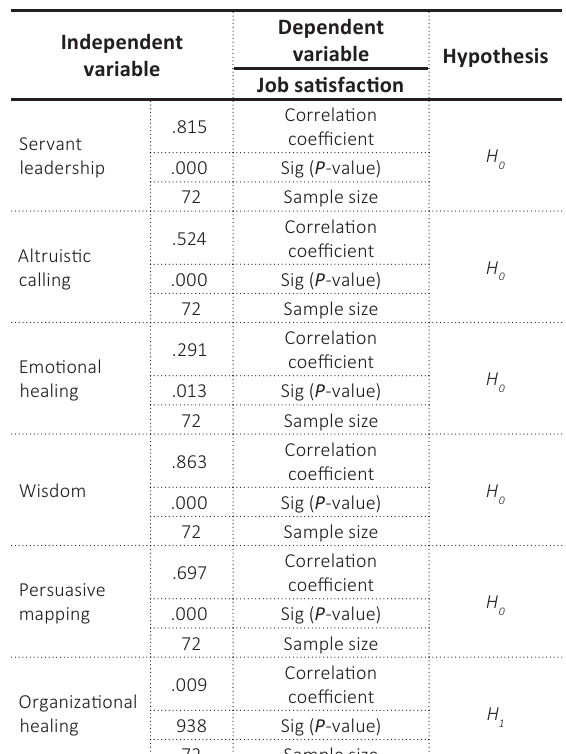
Table 3. Simple sample T-test results